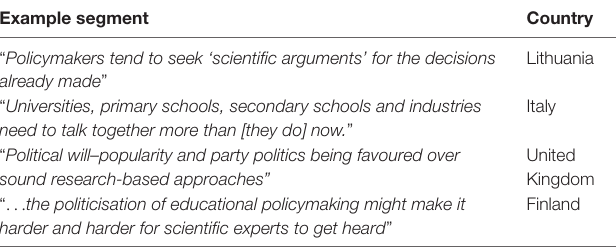
TABLE 1 | Example segments with policymakers’ views on traditional decision-making processes in education policy. Example segment Country